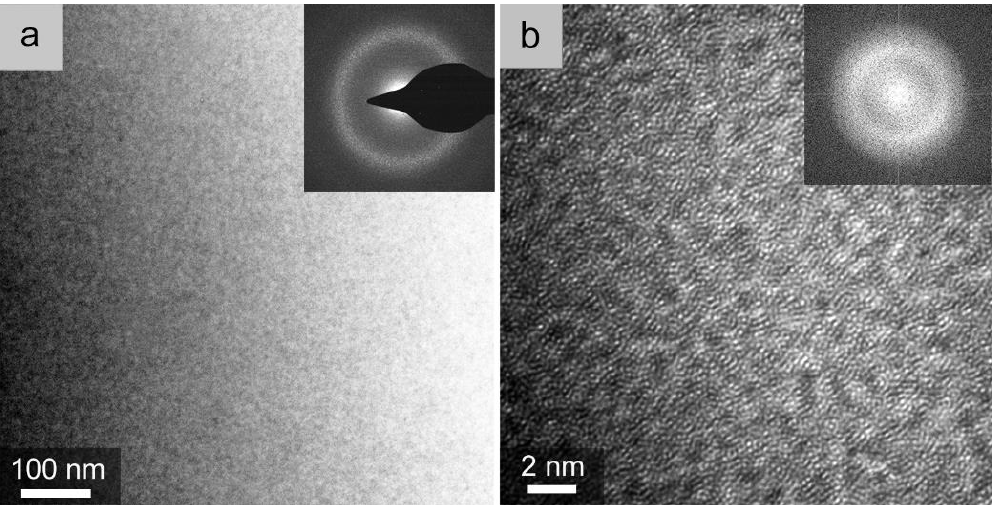
Figure 3. ( a ) Transmission electron microscopy (TEM) micrograph and ( b ) high-resolution TEM (HRTEM) image of the Vit.1 strip with insets of the selected-area electron di ff raction (SAED) and fast-Fourier transform (FFT) patterns,